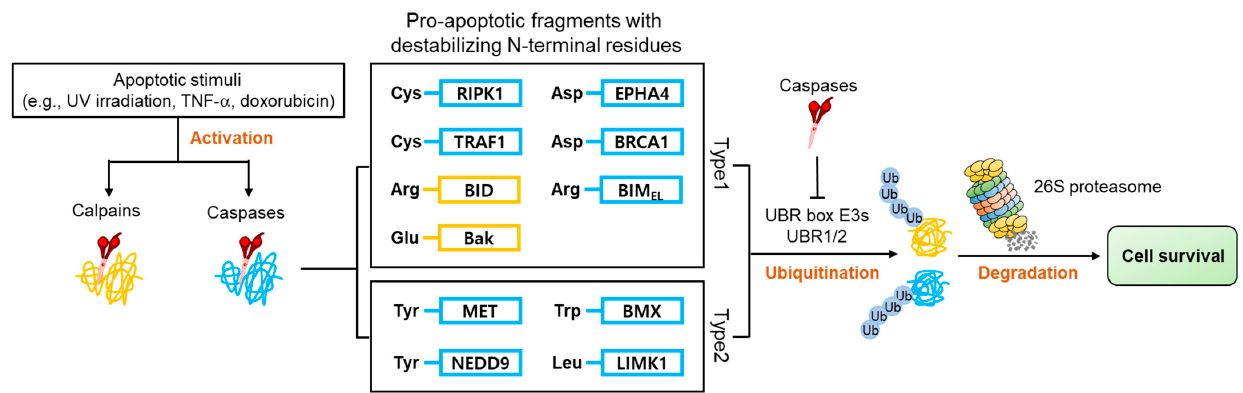
Figure 8. A model depicting the degradation of pro-apoptotic fragments mediated by UBR1/2 in response to apoptotic stimuli. Caspases or calpains generate pro-apoptotic fragments during the induction of apoptosis. These proteins expose destabilizing residues at the N-terminus, which are short-lived N-degron substrates. As a result, these pro-apoptotic fragments are selectively degraded by the Arg/N-degron pathway, contributing to cell survival. As a negative feedback mechanism, caspases can also inhibit UBR1 function by inducing its cleavage.